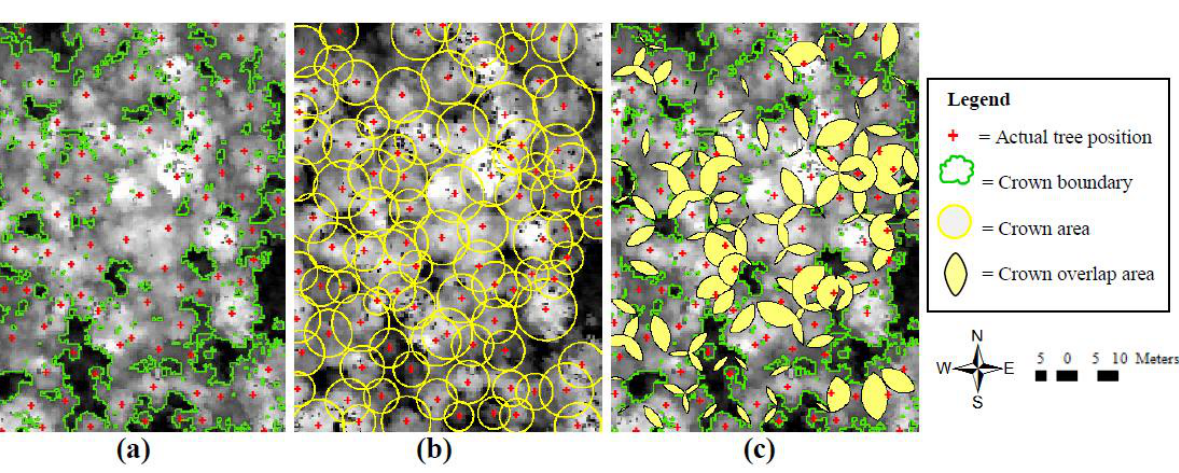
Figure 3. The process of crown overlap extractions: ( a ) the CHM was separated into crown and non-crown areas (green boundary); ( b ) actual stem positions were used as a centroid for generating the circular buffer, based on the field radius (yellow circle); and ( c ) the crown overlap areas are the intersected regions (yellow